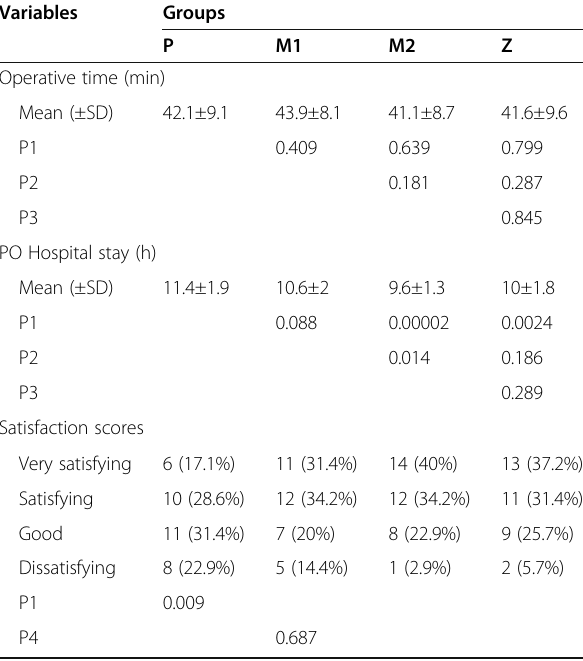
Table 4 Operative and PO data of patients of the four groups Variables